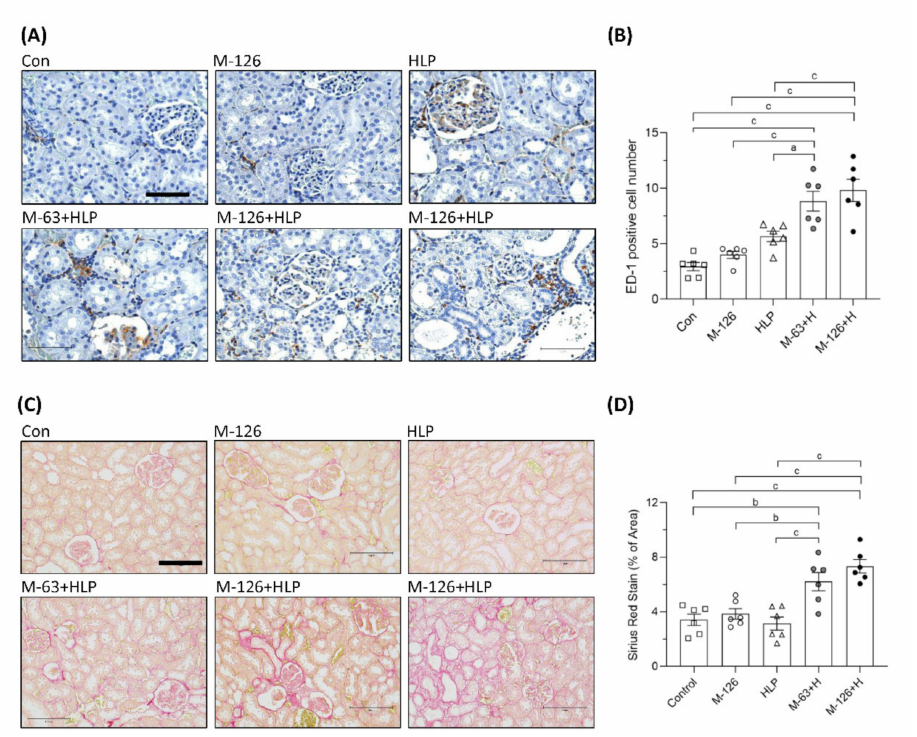
Figure 5. Inflammation and fibrosis in kidneys of the SD rats. ( A ) ED-1 IHC staining in kidneys of the rats. Brown color (DAB substrate) stains indicate macrophages (ED-1 positive stained cells) infiltration to renal tubulointerstitium, suggesting chronic inflammation occurred in kidneys of the rats coexposed to melamine and HLP. Scale bar = 75 µ M. ( B ) Quantified results for the ED-1 positive stains. ( C ) Representative images of Picrosirius Red staining in kidneys of the rats. Red color stains in the kidneys indicate that positive staining of extracellular matrix proteins accumulate in tubulointerstitium, suggesting occurrence of renal fibrosis. Scale bar = 150 µ M. ( D ) Quantified results for the fibrosis degree (red color) in the kidneys. Con: control; HLP or H: 2% hydroxy-L-proline; M-126: melamine 126 mg/kg/day; M-63: melamine 63 mg/kg/day. Data are mean ± SE from six rats of each group in the third batch animal experiment. a: p < 0.05; b: p < 0.01; c: p <